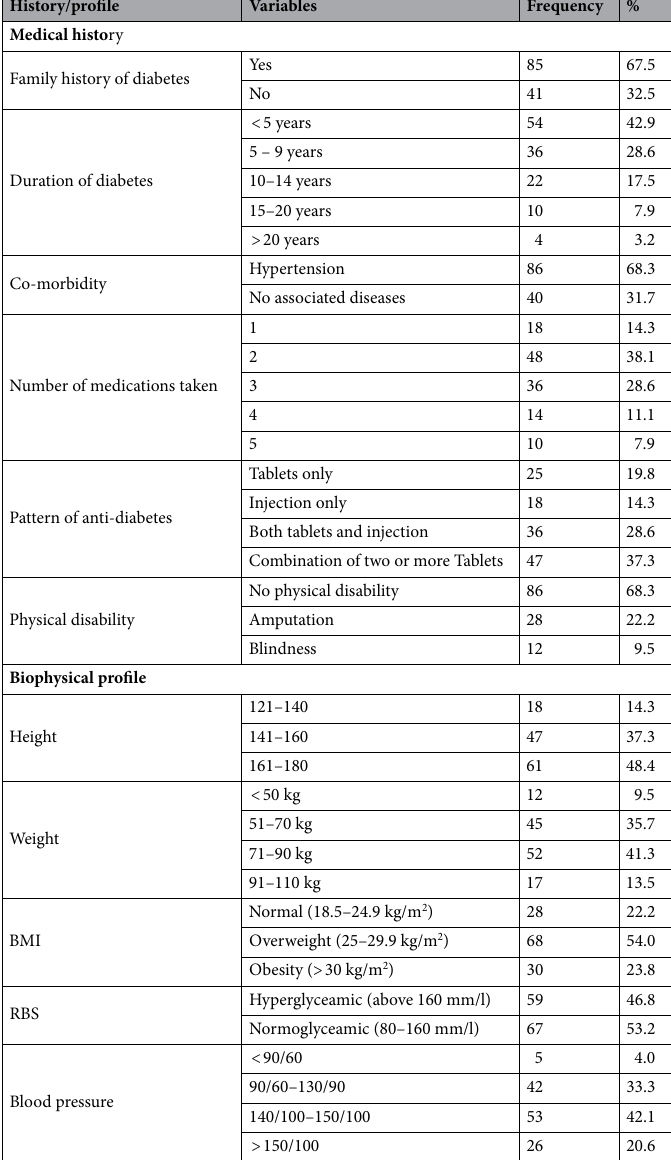
Table 2. Medical history and biophysical profile of the respondents (N =